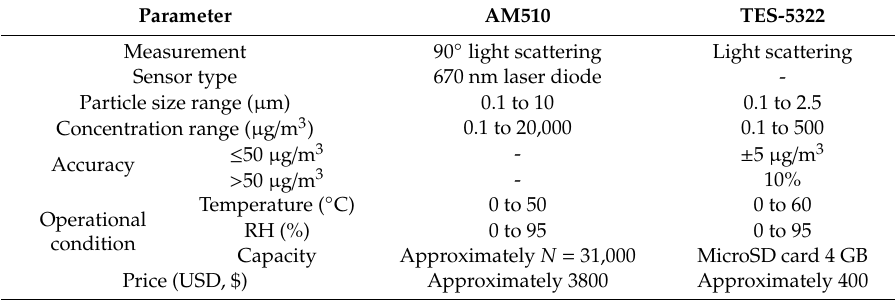
Table 1. Specifications of the particulate matter (PM) 2.5 measuring instrument used in this